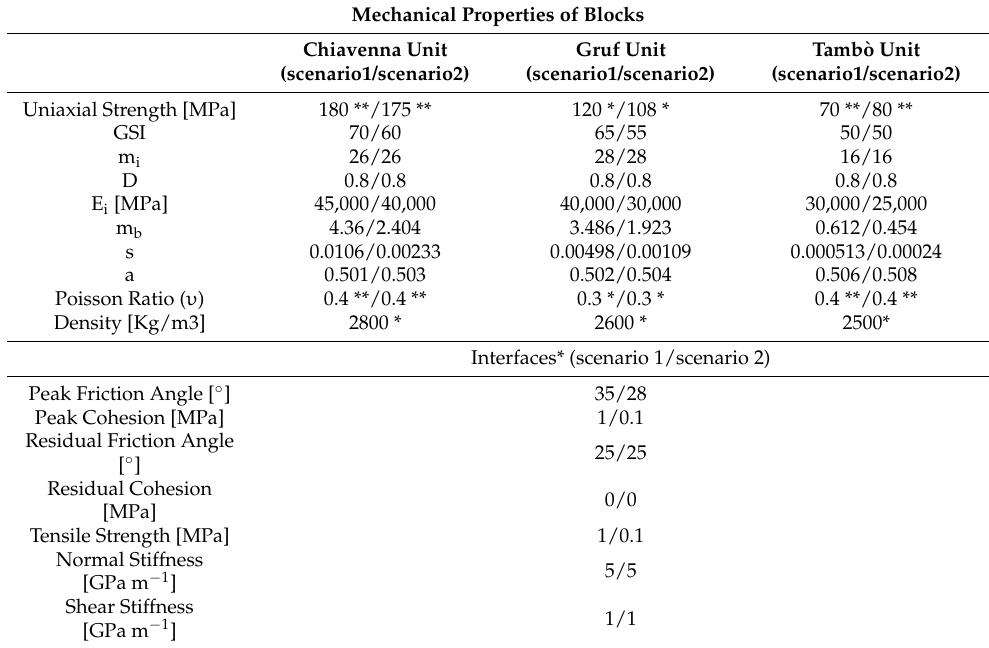
Table 1. Mechanical elasto-plastic properties of blocks and interfaces. (*) Derived from laboratory tests conducted as part of the present study. (**) Derived from laboratory tests conducted by Apuani T. (previous work not